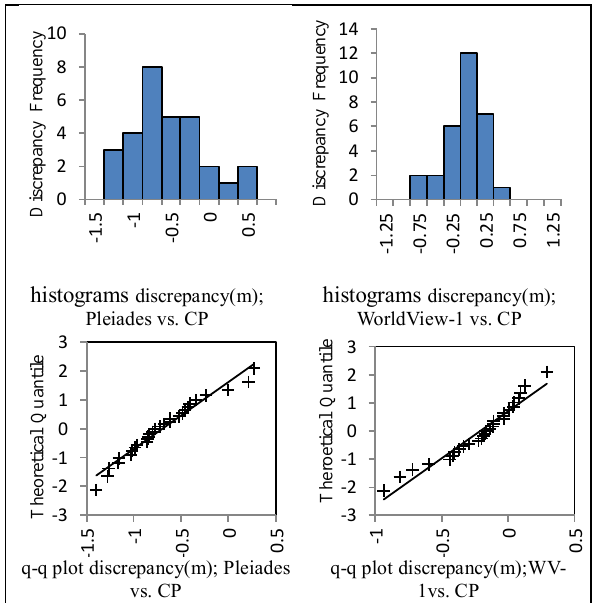
Figure 2. Original DSMs (Pleiades and WV-1) error distribution histograms and q-q plot against RTK check